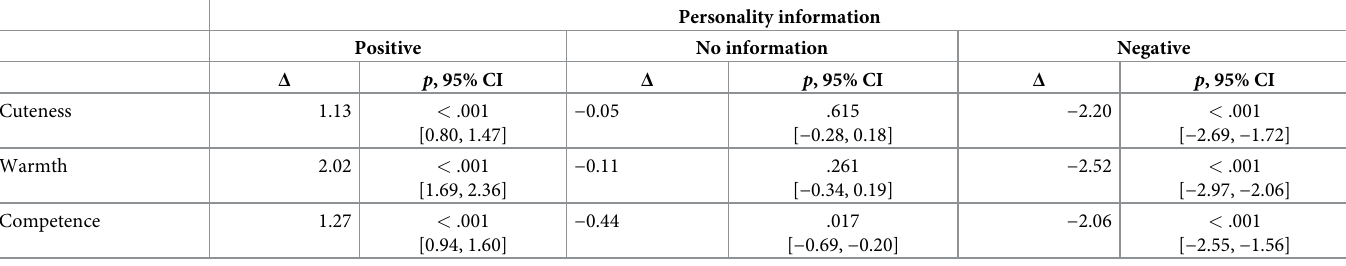
Table 1. Changes in cuteness, warmth, and competence ratings from pre-evaluation to post-evaluation (Study